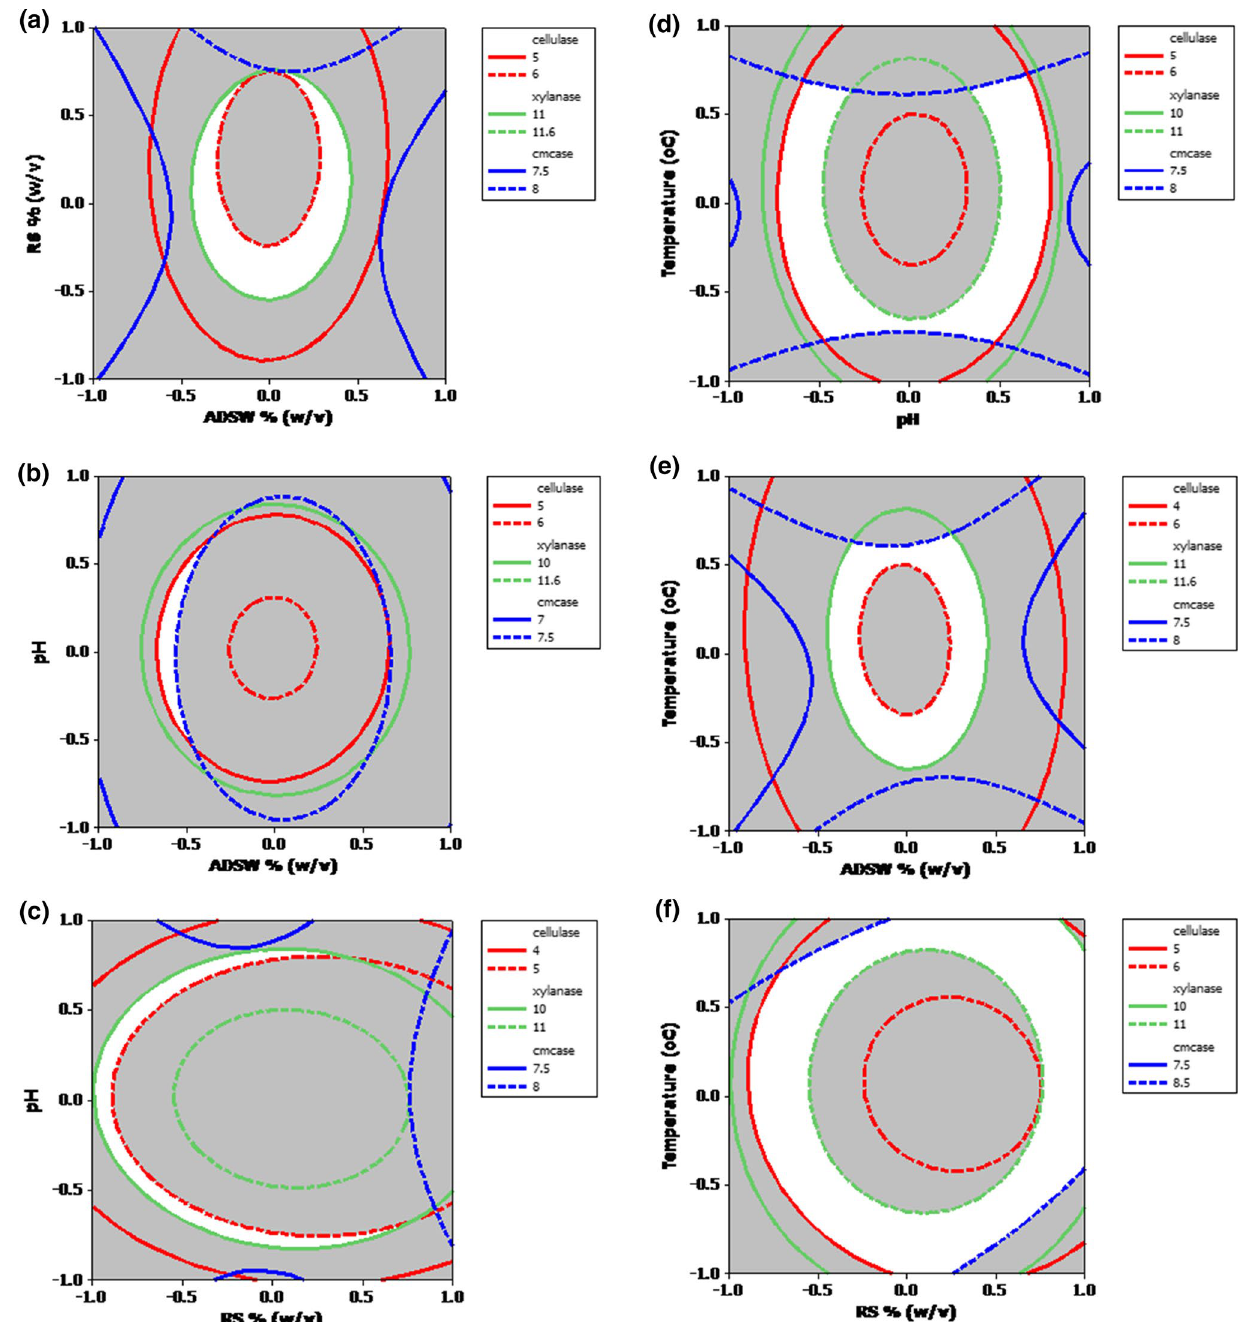
Fig. 1 Overlaid contour plot for the effects of a ADSW (% v/v) and RS (% w/v), b pH and ADSW (% v/v), c pH and RS (%w/v), d pH and tem- perature (°C), e temperature (°C) and ADSW (% v/v), f RS (%w/v) and temperature (°C), on enzyme production by A. activities share the same optimum range of ADSW conc. for Figure 1b shows the interactive effect of pH and ADSW maximum enzyme activity, but different optimum range of conc. on enzyme activities. The white portion of Fig. 1b rice straw concentration as 3.5% for exoglucanase and 3.0% shows that maximum enzyme activities were observed at for xylanase activity. Highest endoglucanase activity was middle value of both ADSW conc. and pH, i.e., 4–8% of observed at 6.3% ADSW conc. and 4.7% rice straw conc., ADSW and 4.5–5.5 of pH. slightly higher than the middle value of studied variables.